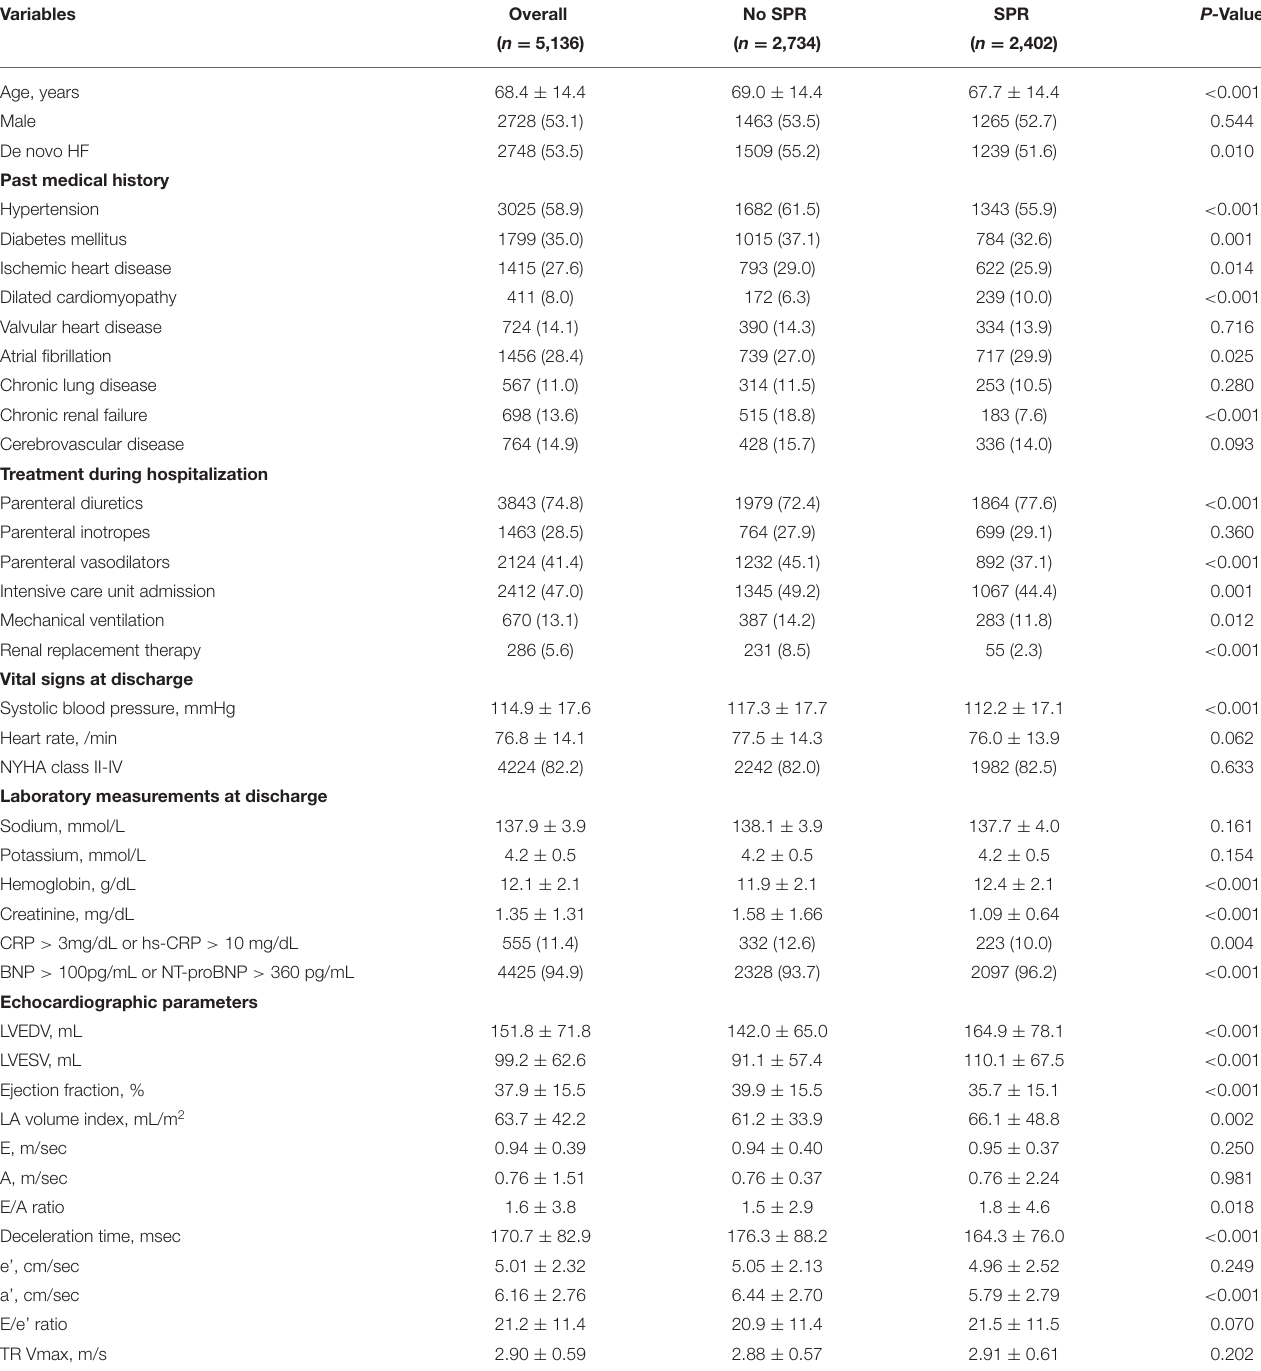
TABLE 1 | Clinical and treatment characteristics in overall patients.